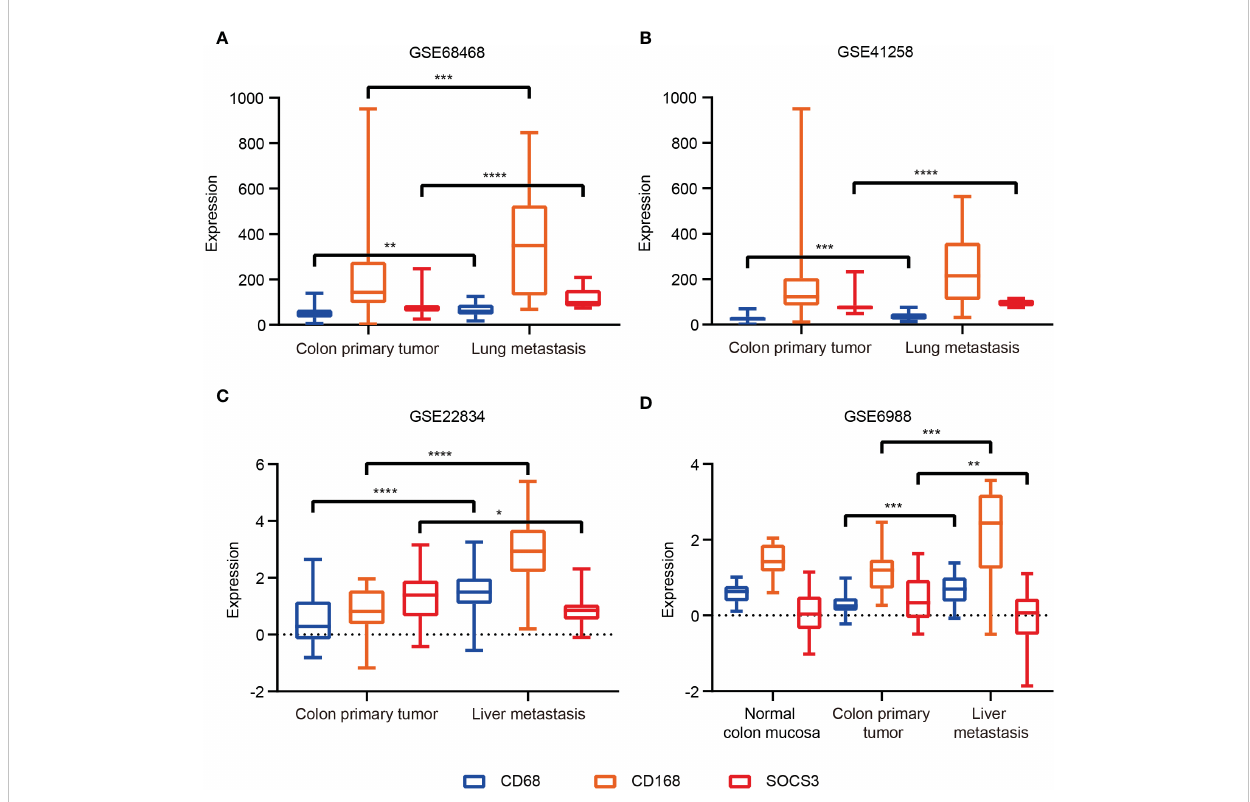
FIGURE 5 The SOCS3 expression difference between colon primary tumor and metastasis in the GEO database. (A) GSE68468; (B) GSE41258; (C) GSE22834; (D) GSE6988. *P < 0.05, **P < 0.01, ***P < 0.001, ****P <